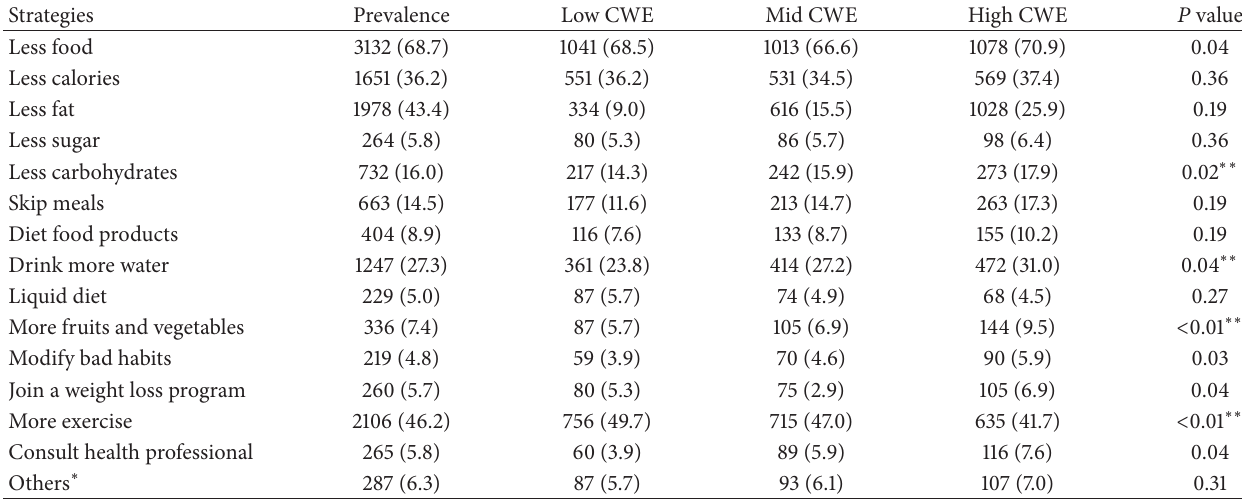
Table 2: Reported strategies to lose weight in the past year.